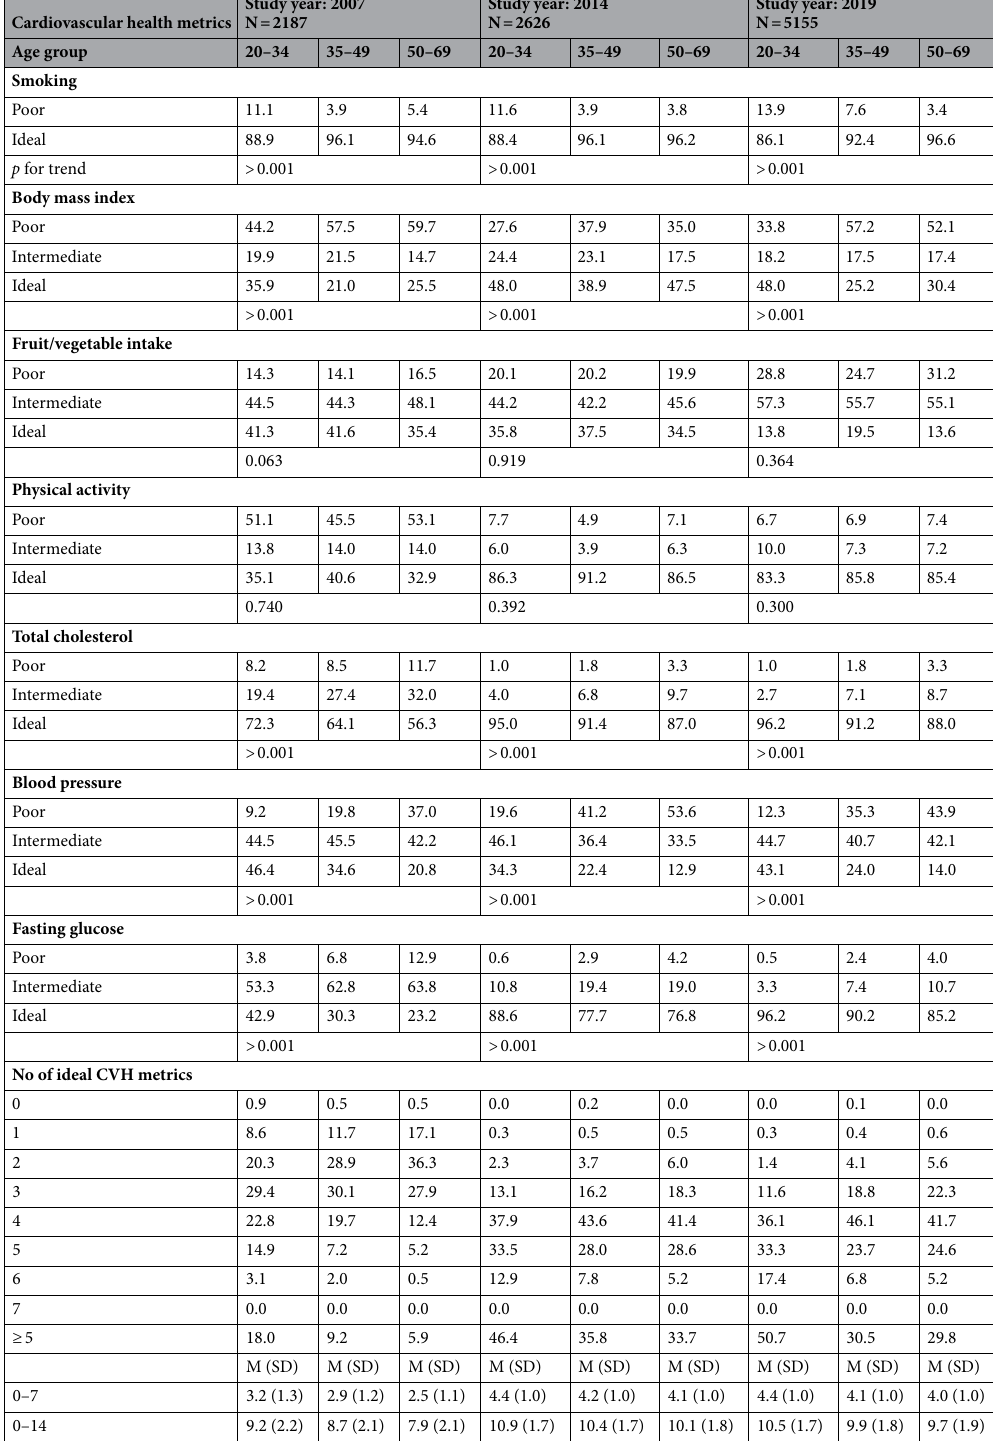
Table 3. Cardiovascular health (CVH) metrics distribution by age group and study year in